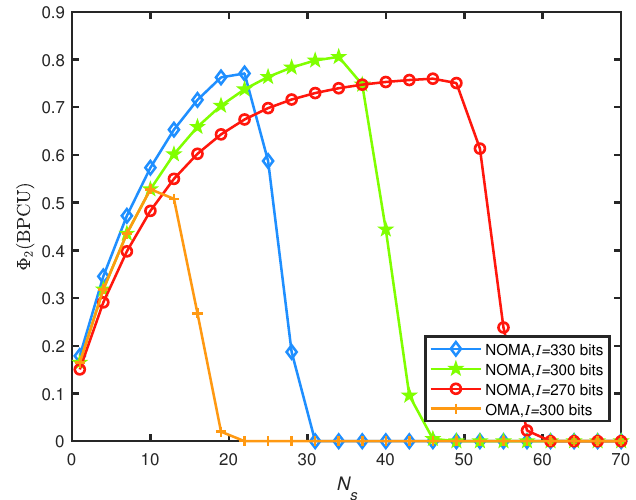
Figure 3. Φ 2 versus the sensing time for different schemes and I